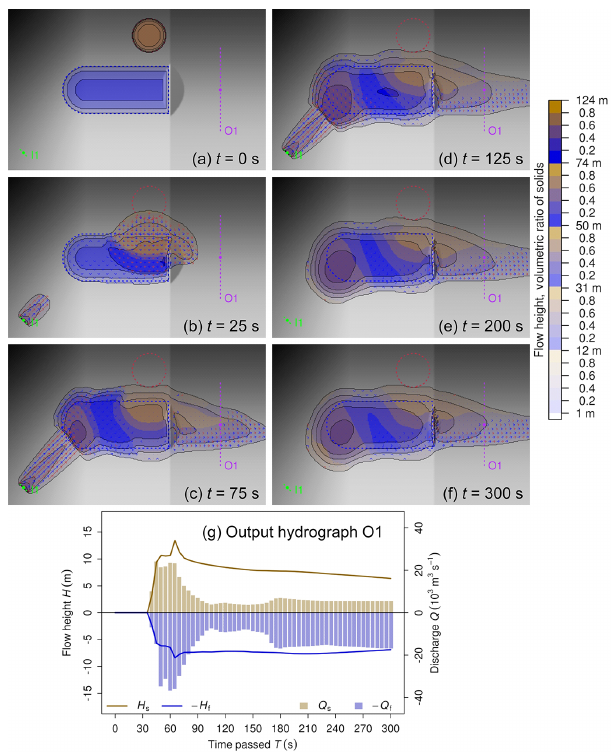
Figure 8. Key results of Experiment 1C. (a–f) Sequence of sim- ulated flow heights and solid ratios at selected points of time; see Animation 1C in the Supplement for animations of flow height se- quences; (g) output hydrograph O1 (see Fig. 5a).